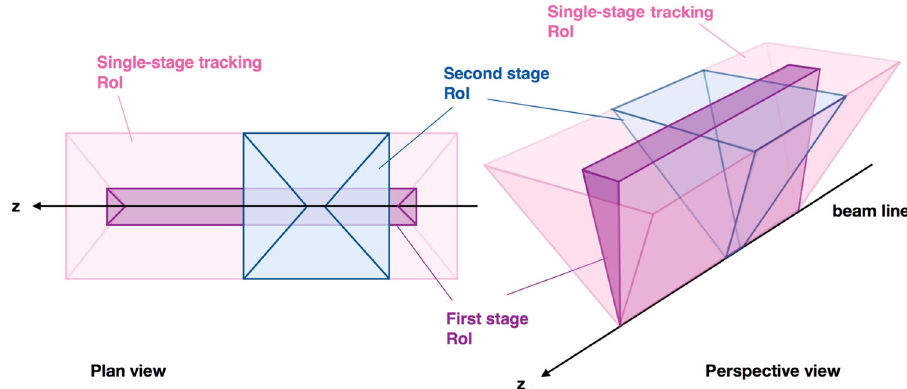
beam line. The combined tracking volume of the 1st and 2nd stage RoI in the two-stage tracking approach is significantly smaller than the RoI